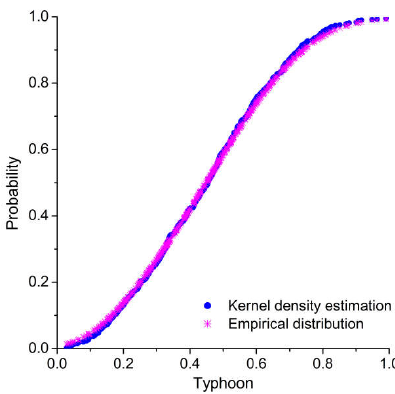
Figure 5. Cumulative probability distribution of typhoon. Int. J. Environ. Res. Public Health 2018 , 15 , x